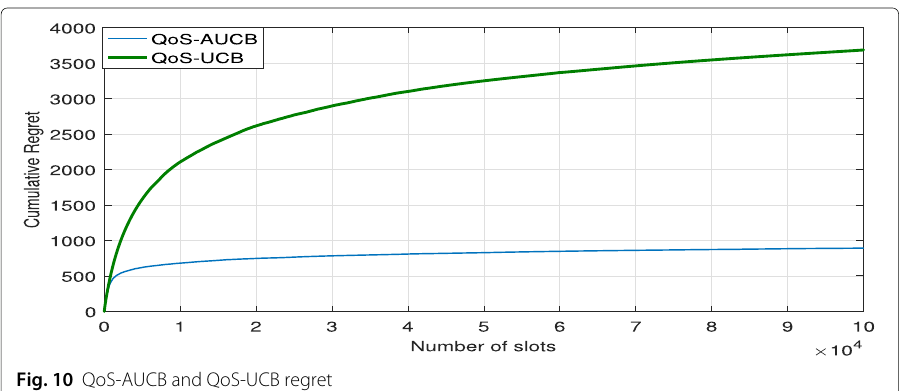
Fig. 10 QoS-AUCB and QoS-UCB